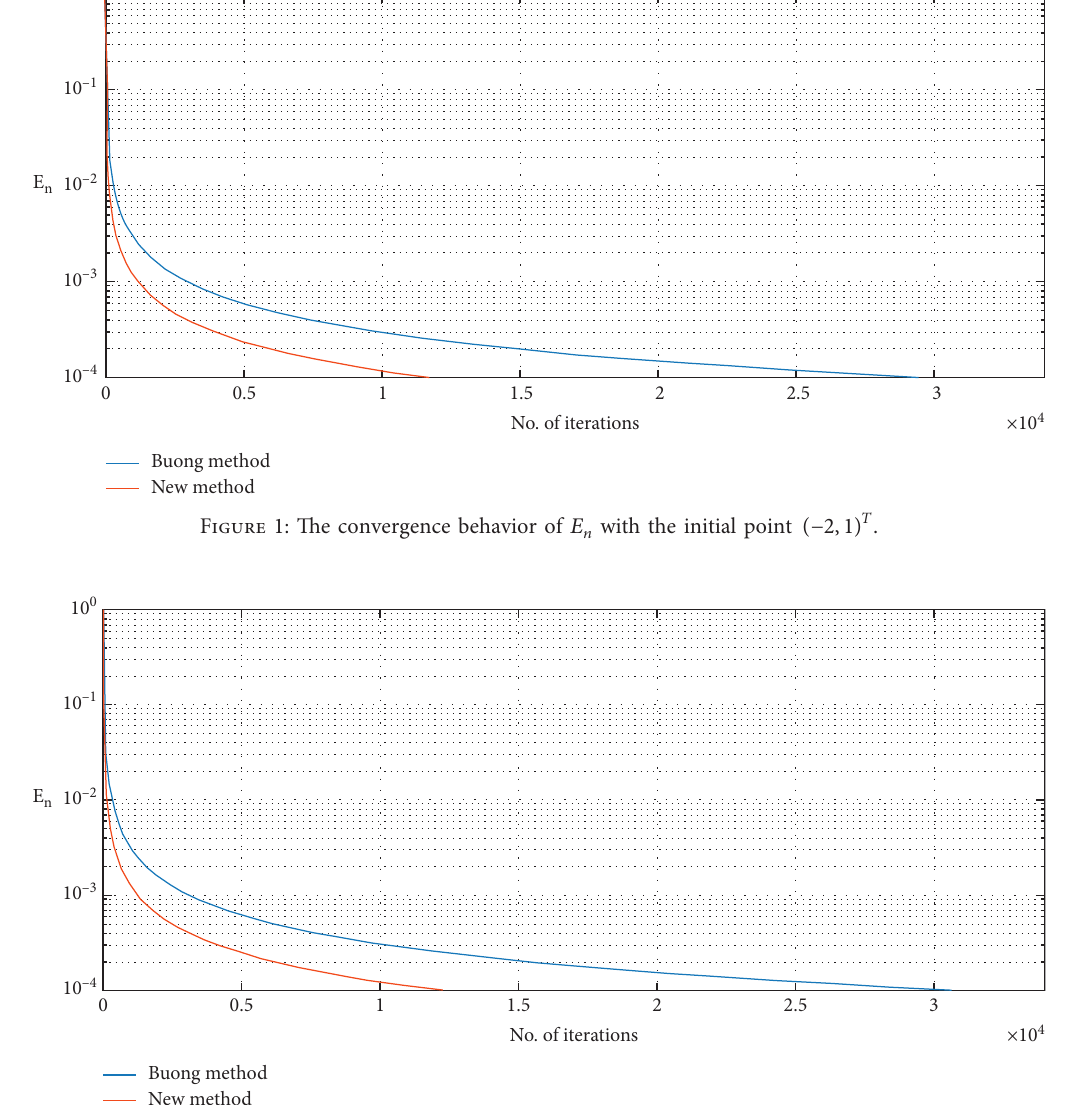
Figure 2: The convergence behavior of E